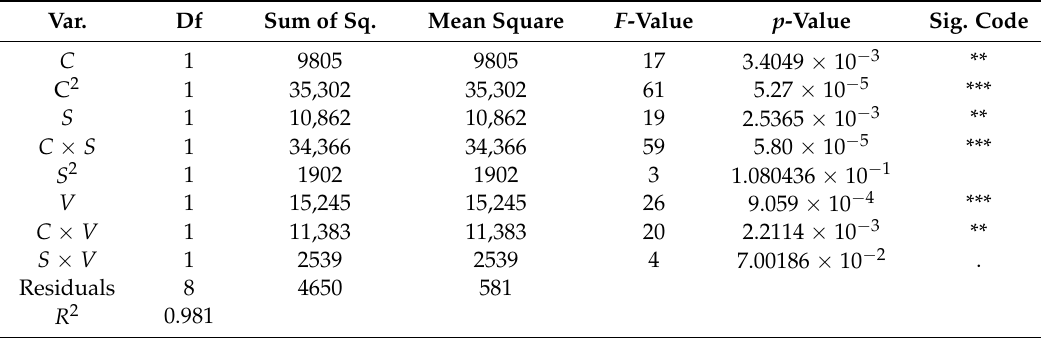
Table 6. ANOVA table for the “YS” quadratic model.